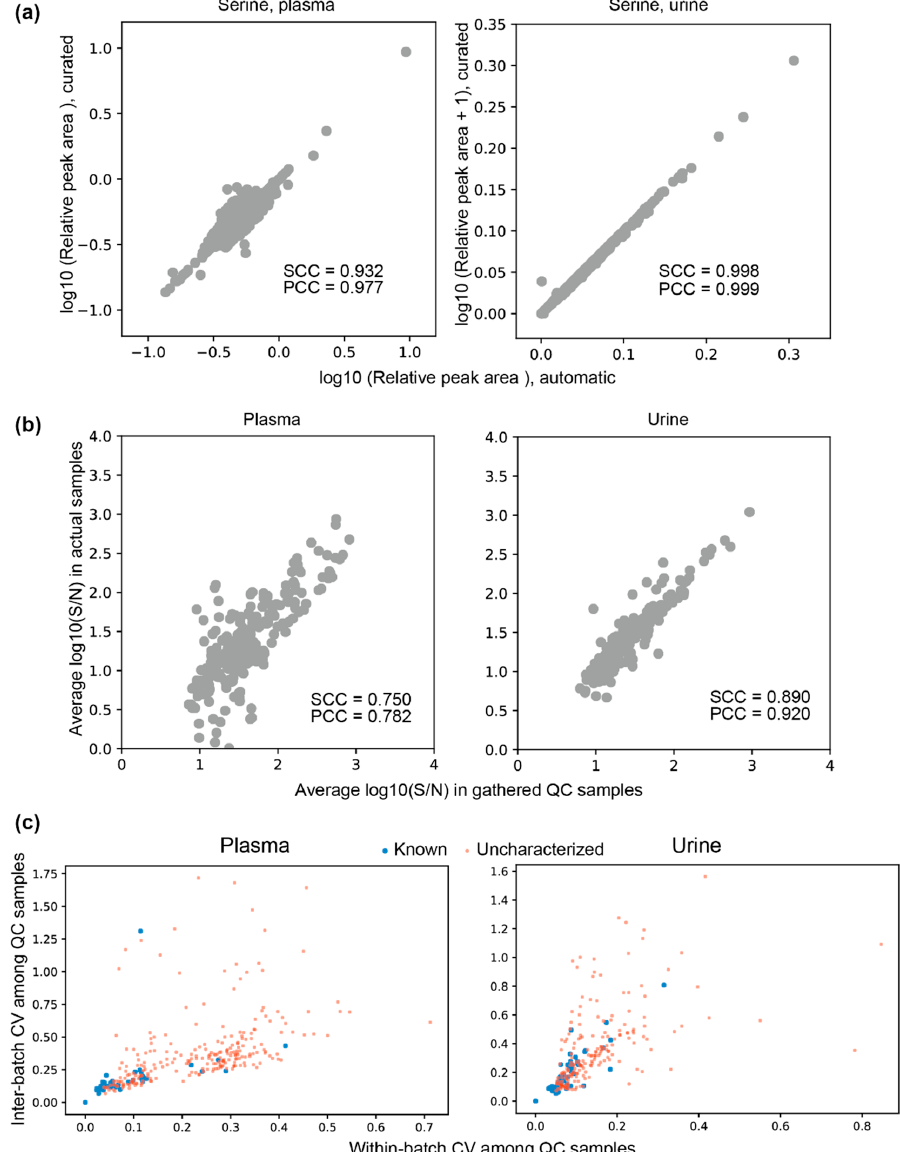
Figure 4. Characteristics of peaks automatically extracted from actual samples and quality control (QC) samples that were measured together within the same batches. ( a ) Plots of relative peak areas that were determined automatically against peak areas that were curated manually. The results for serine are shown. ( b ) Plots of average signal-to-noise (S/N) ratios of uncharacterized peaks in the QC samples against the corresponding S/N ratios in the actual samples. ( c ) Plots of within-batch coefficient of variations (CVs) against inter-batch CVs of relative areas of known and uncharacterized peaks among QC samples. The points at (0,0) indicate the internal standard. SCC, Spearman’s correlation coefficient; PCC, Pearson’s correlation coefficient.